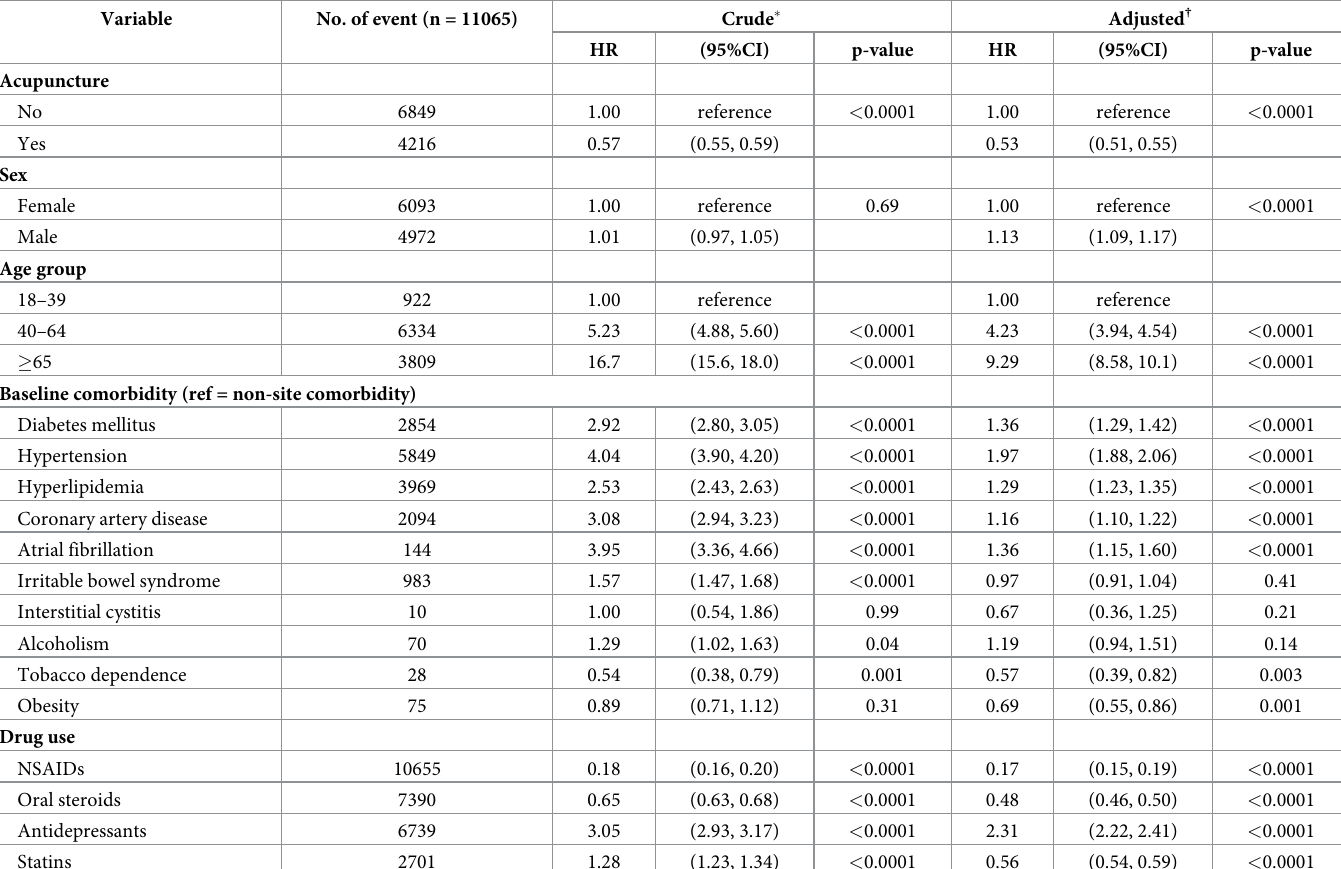
Table 2. Cox model with hazard ratios and 95% confidence intervals of stroke according to whether the patients underwent acupuncture and other covariates among the fibromyalgia patients.